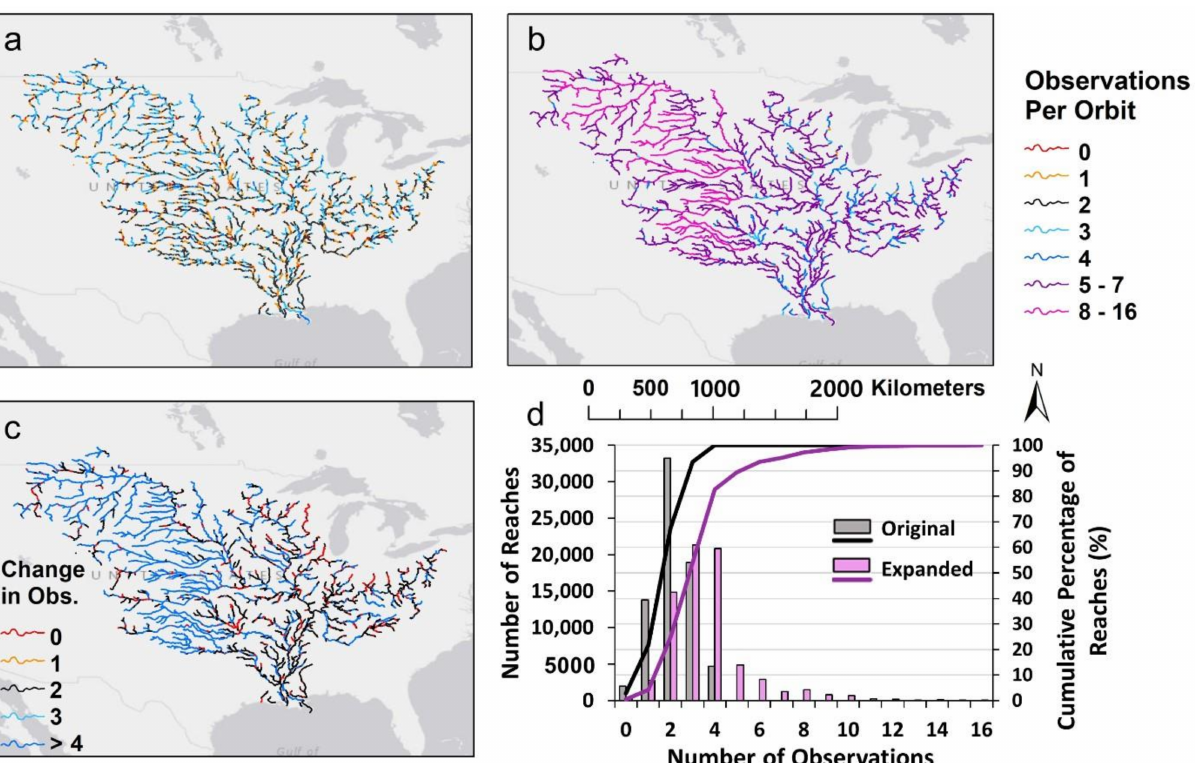
Figure 8. All study reaches in the Mississippi River basin classified by ( a ) the original number of SWOT observations per 21-day orbit cycle without drainage area ratio method expansion, ( b ) the number of SWOT observations per 21-day orbit cycle with drainage area ratio method expansion for ratios between 0.01 and 100, using only donations without dams and urbanization less than 196 km 2 between reaches, and ( c ) the change in observations between ( a ) and ( b ). ( d ) The number (bars) and cumulative percent (lines) of reaches observed categorized by the number of SWOT observations per orbit. Color indicates which map the statistics describe. Black gives the original quantity of reaches that are observed a specific number of times by SWOT ( a ) and purple represents that of the expanded study quantities ( b